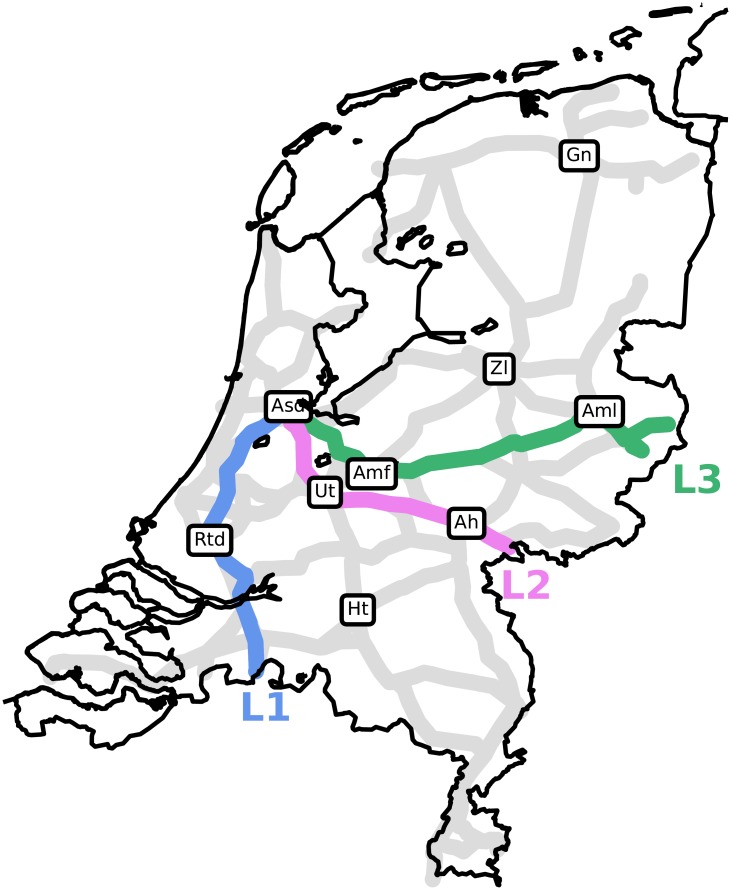
Three important lines L1, L2 and L3.Abbreviations as in Fig 2.